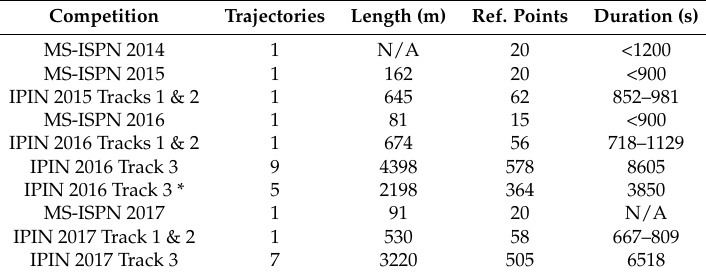
Table 7. Indoor Competitions—Features of the evaluation